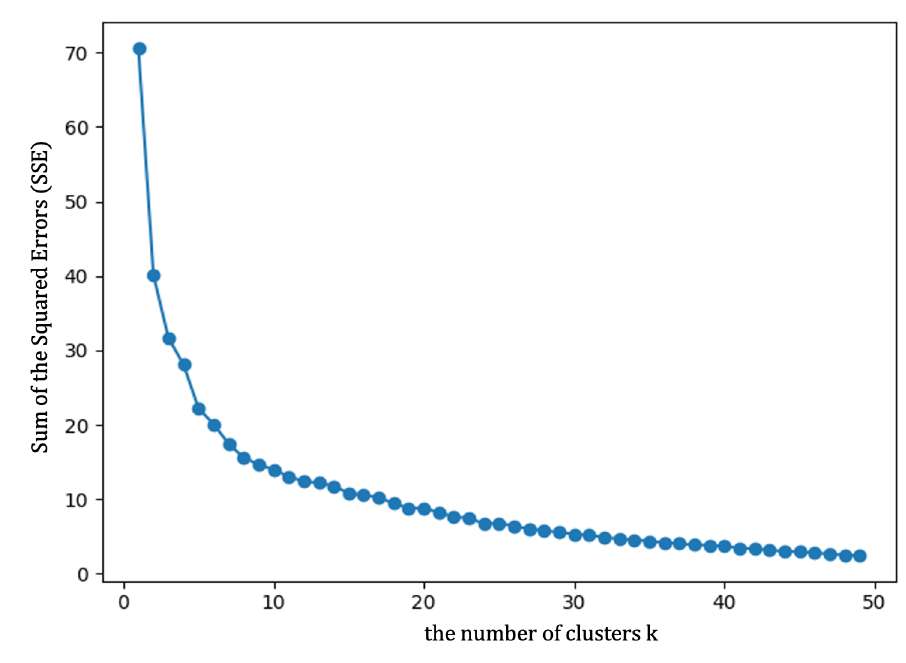
Figure 6. Determination of the cluster number using the elbow